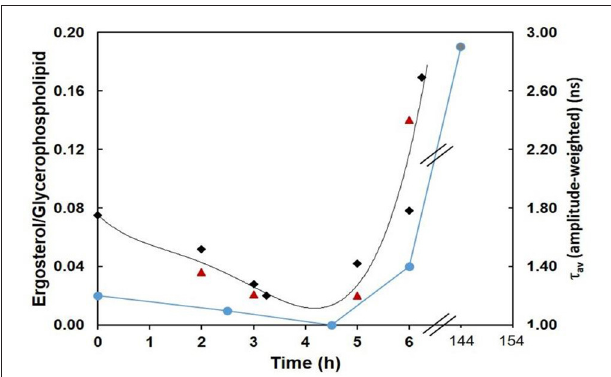
FIGURE 10 | Ergosterol/Glycerophospholipid ratio (Bianchi and Turian, 1967; Kushwaha et al., 1976) (blue), and amplitude-weighted mean fluorescence lifetime of di-4-ANEPPS at 30 ◦ C, in the absence (CTRL, black) or in the presence of STS (red) vs. time of growth (this work and Santos et al., 2017). The last blue data point corresponds to the composition of mycelium (6 days growth). The lines are merely to guide the eye.